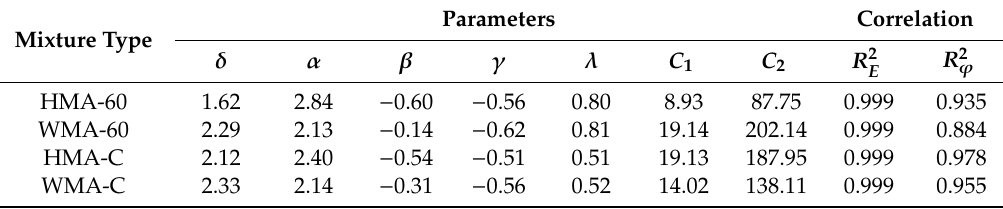
Table 7. Fitting parameters of the GSM (WLF equation)